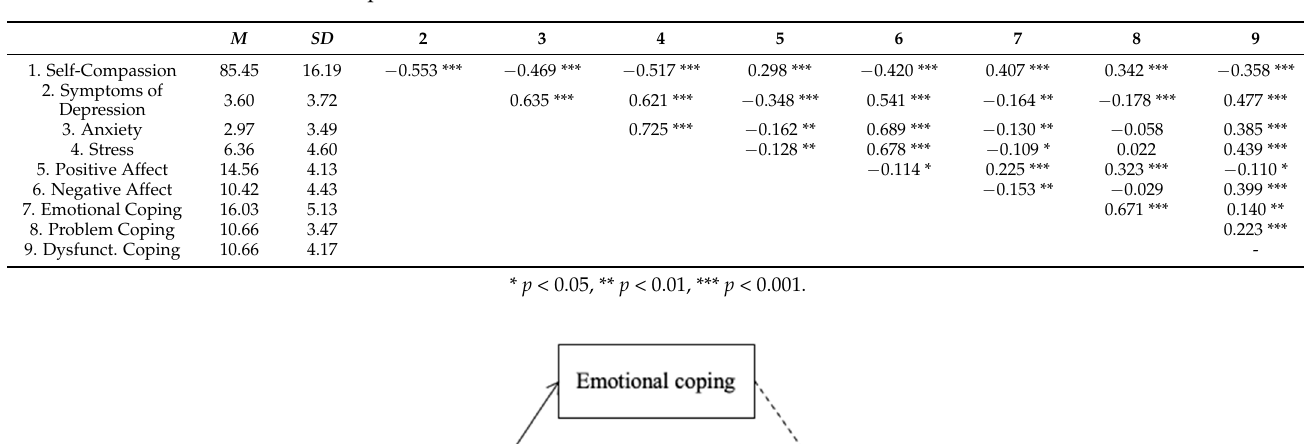
Table 1. Descriptive statistics and correlations of the variables of interest for Models 1 − 3.